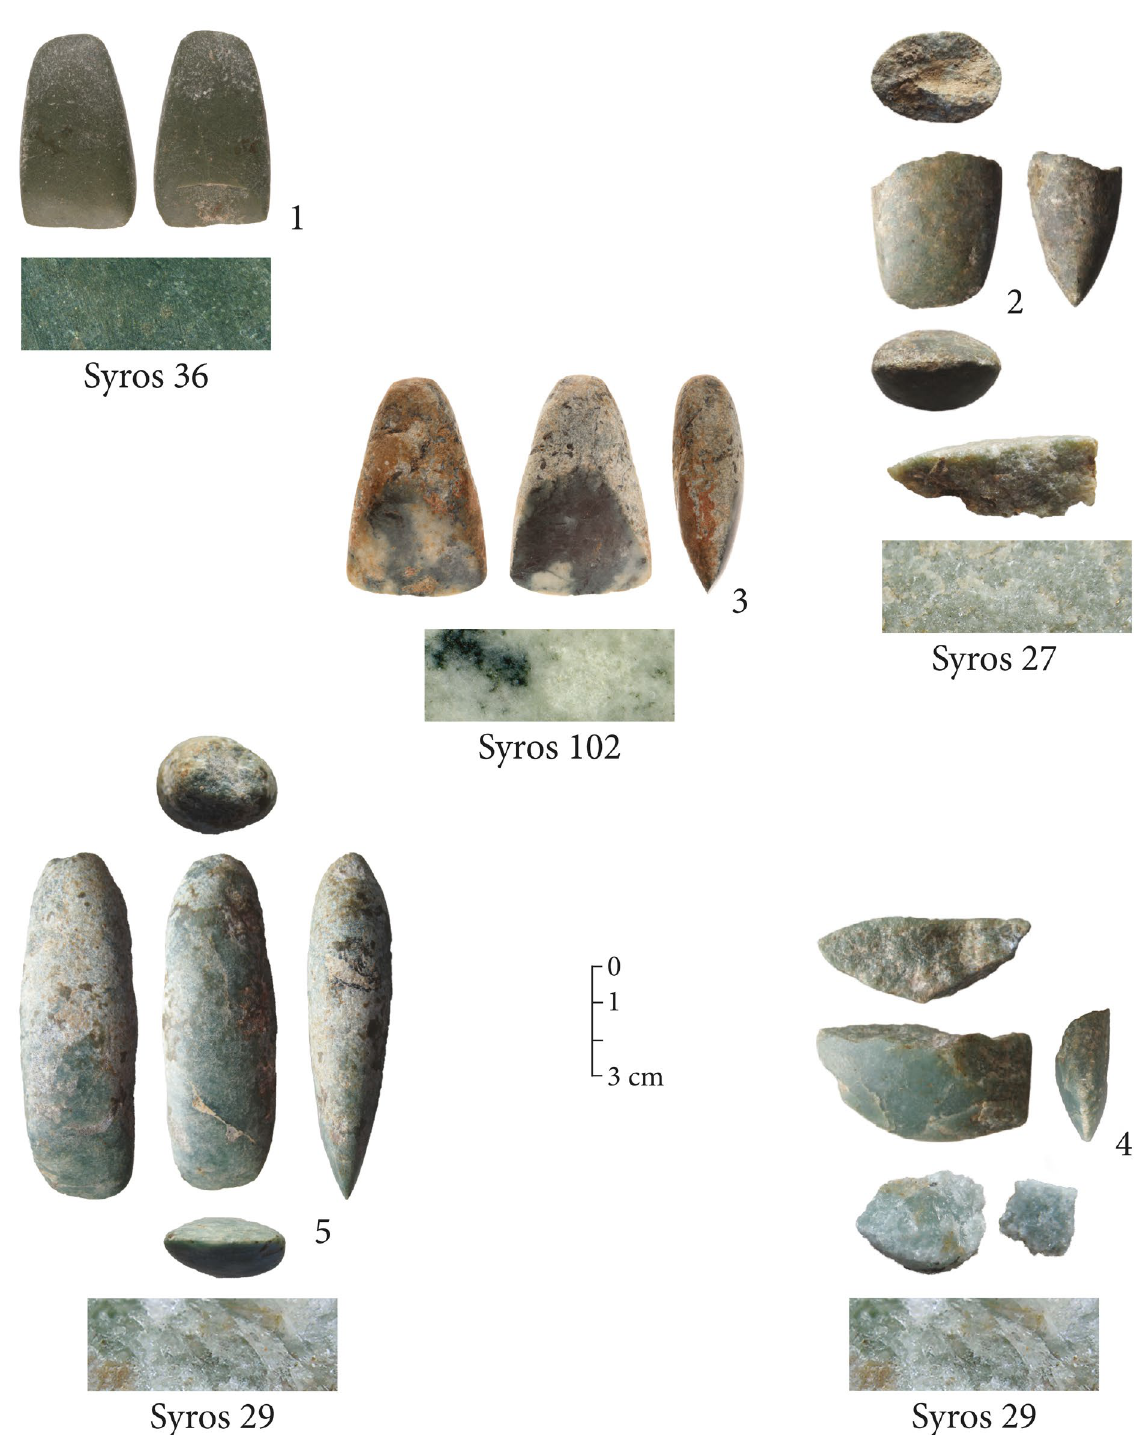
Figure 8. Jadeite axes from Çukuriçi Höyük and below comparisons with geological jadeite samples from Syros: 1: 1722 , ÇuHö XI; sample Syros 36; 2: 1832 , ÇuHö IX, sample Syros 27, 3: 318 , ÇuHö IV; sample Syros 102; 4: 320 , ÇuHö II, sample Syros 29; 5: 501 , ÇuHö I; sample Syros 29 (graphic by L.